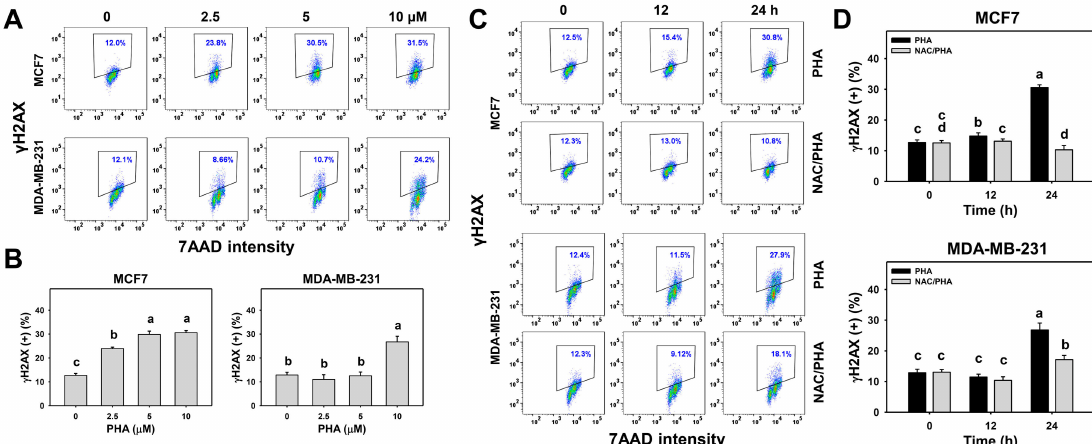
Figure 8. PHA triggered γ H2AX overexpression in two breast cancer cell lines. ( A , B ) γ H2AX patterns and statistical analysis for concentration responses of PHA. Cells were incubated with PHA (0 (0.05% DMSO as control), 2.5, 5, and 10 µ M) for 24 h. Small box indicates γ H2AX (+) (%). ( C , D ) Patterns and statistical analysis for NAC pretreatment responses in γ H2AX intensity changes in PHA-post-treated breast cancer cells. Following pretreatment with NAC, cells were processed with post-treatment for 0 (control with 0.05% DMSO) and 10 µ M PHA for 0, 12, and 24 h, i.e., PHA and NAC/PHA. Data, means ± SDs ( n = 3 independent experiments). Experiments without the same top-labeled letters indicate significant changes according to multiple comparisons ( p < 0.05 to